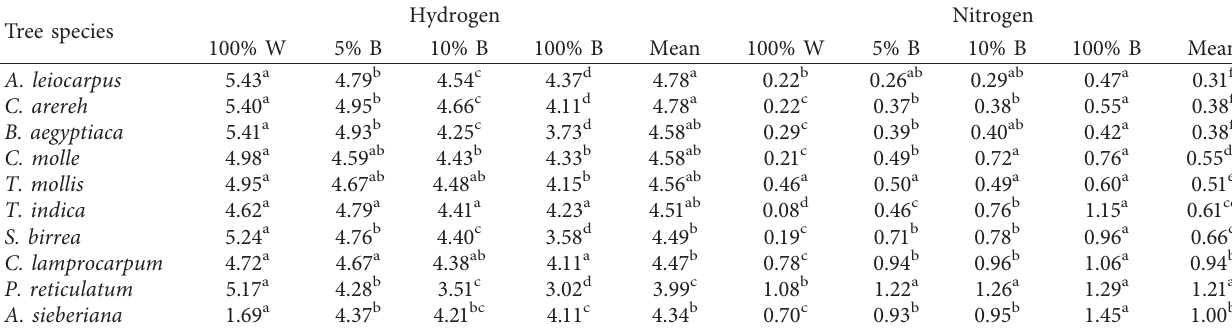
Table 2: Effect of bark inclusion on hydrogen and nitrogen contents (%) of selected fuelwood species. Tree species